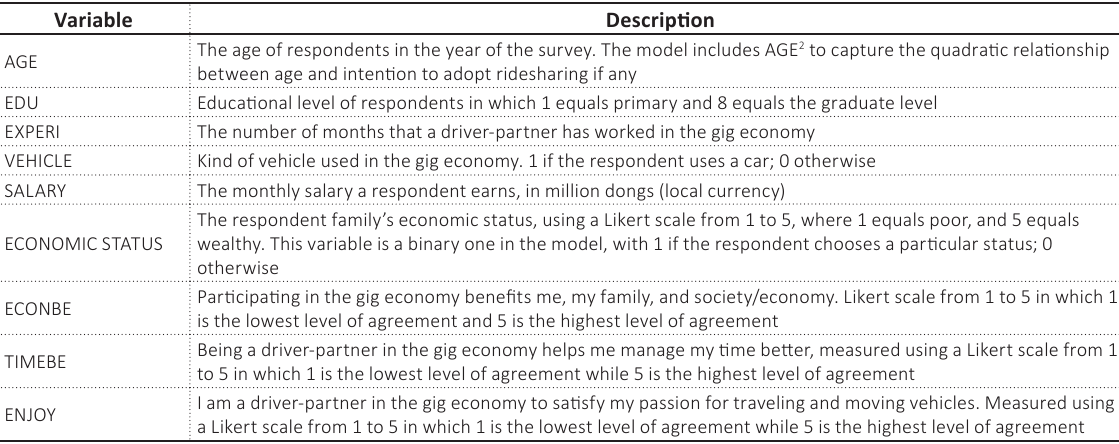
Table 3. Main independent and control variables Variable